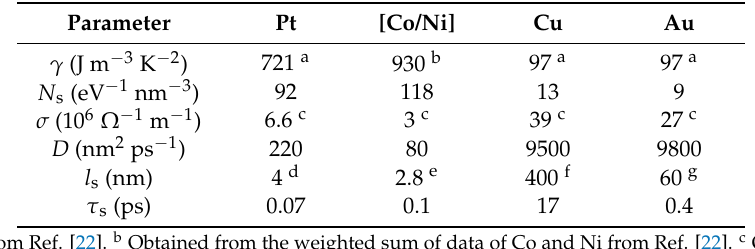
Table 1. Bulk parameters for the spin diffusion modeling. γ is the electronic heat capacity coefficient, N s is the spin density of states, σ is the electrical conductivity, D is the diffusion constant, l s is the spin diffusion length, and τ s is the spin relaxation time.